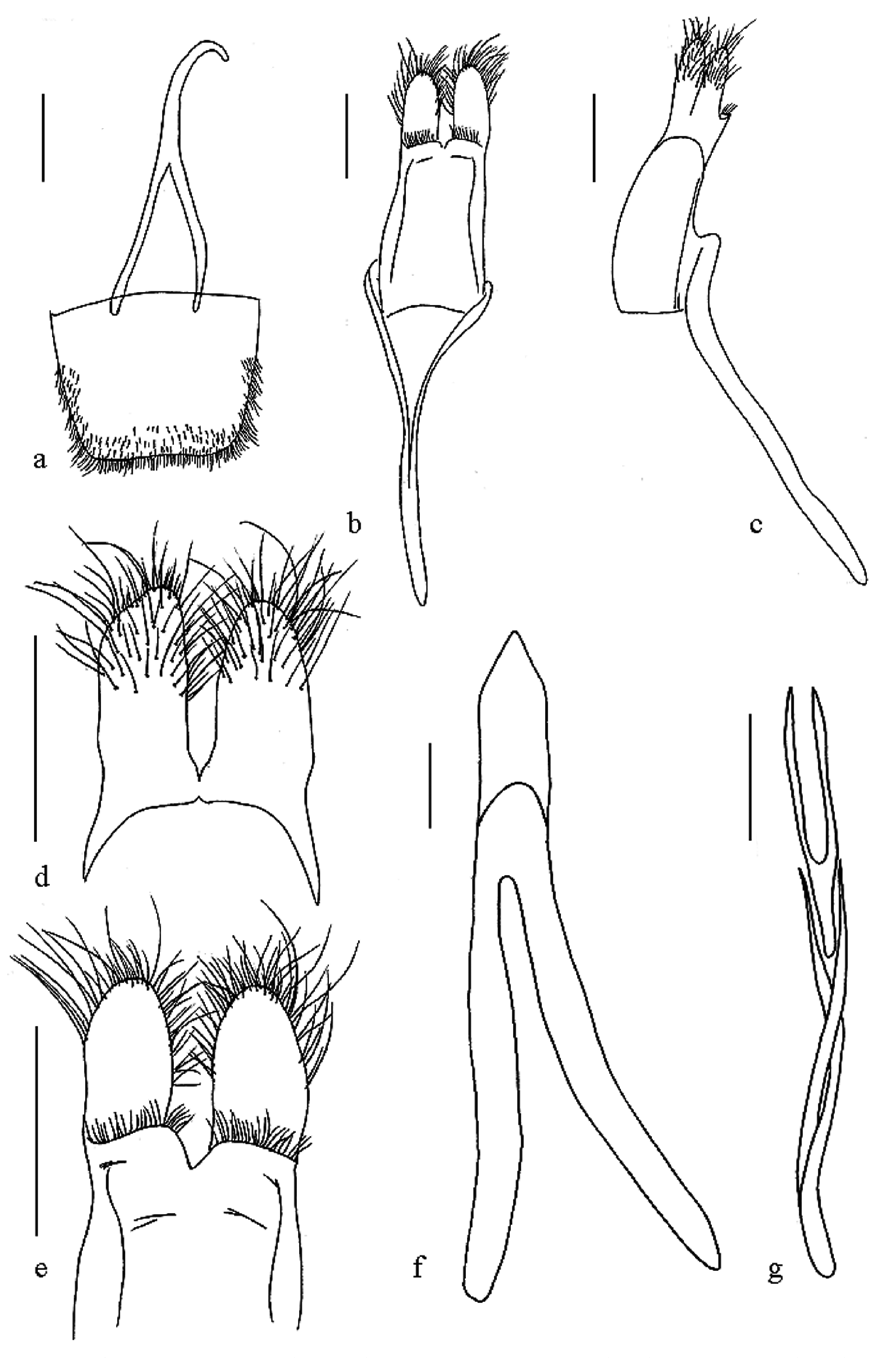
Figure 5. Oberea atropunctata , male genitalia, a tergite viii b tegmen, dorsal view c tegmen, lateral view d parameres, dorsal view, e parameres, ventral view f median lobe, ventral view g sclerities in endophallus. Scale bar 0.5